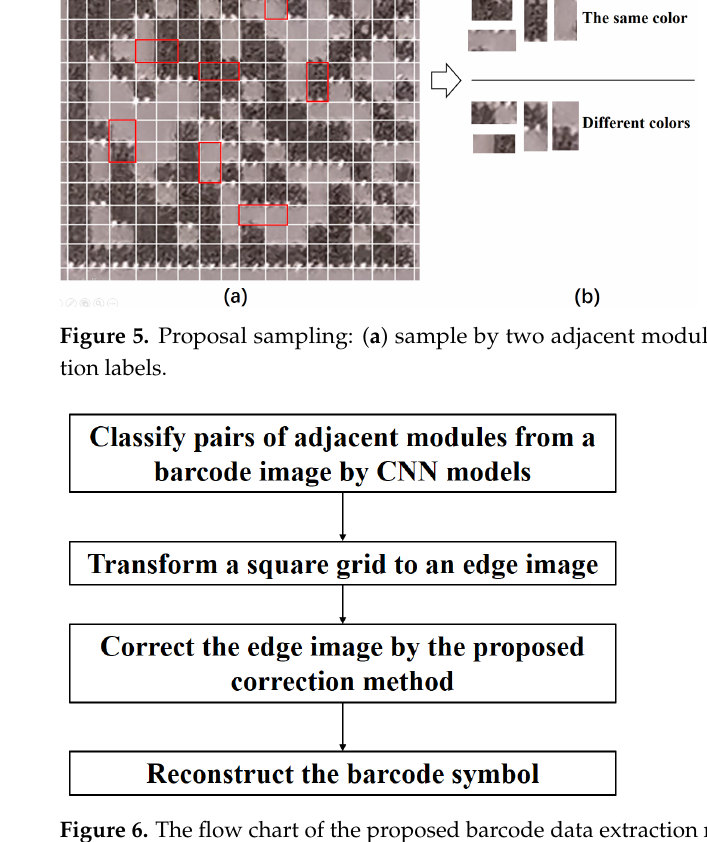
Figure 6. The flow chart of the proposed barcode data extraction method.